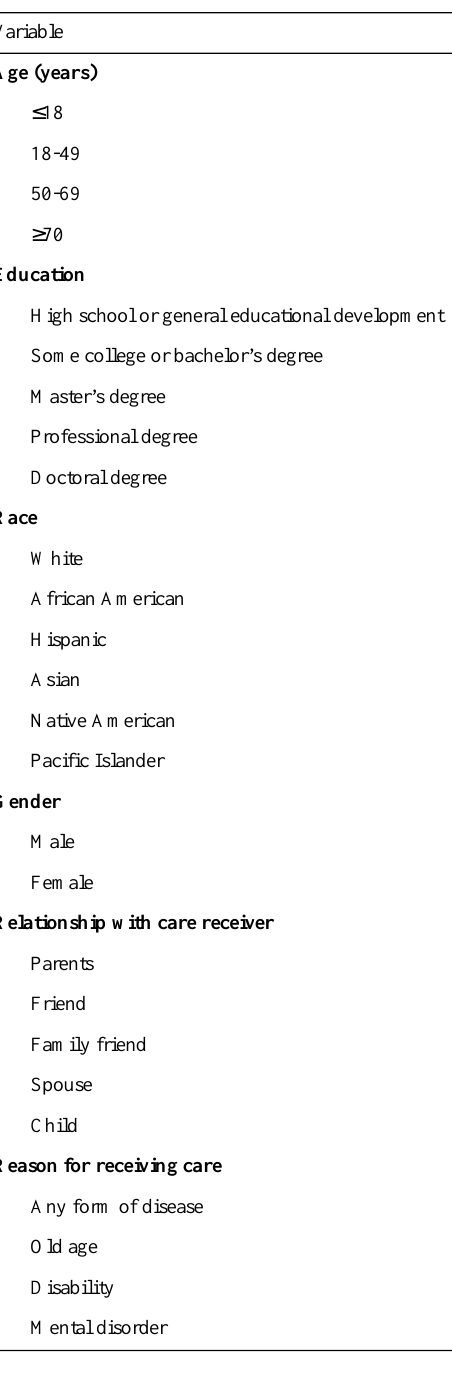
Table 3. Key demographics of care